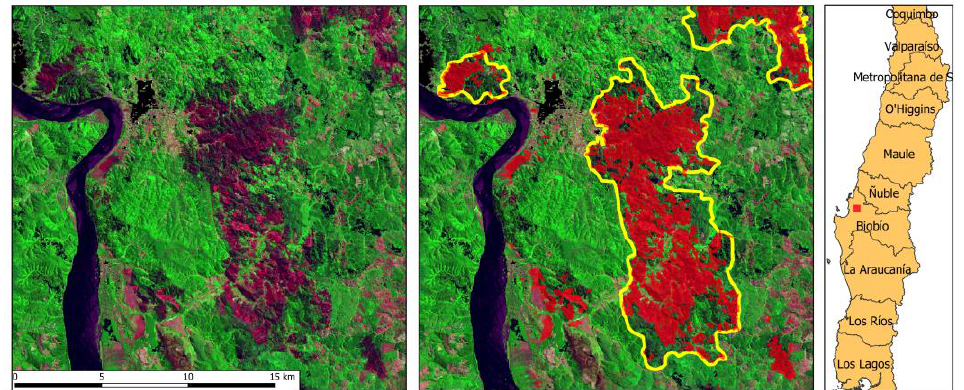
Figure 3. Comparison between BA product (red) and CONAF perimeters (yellow) in a sample area located in the Biobío